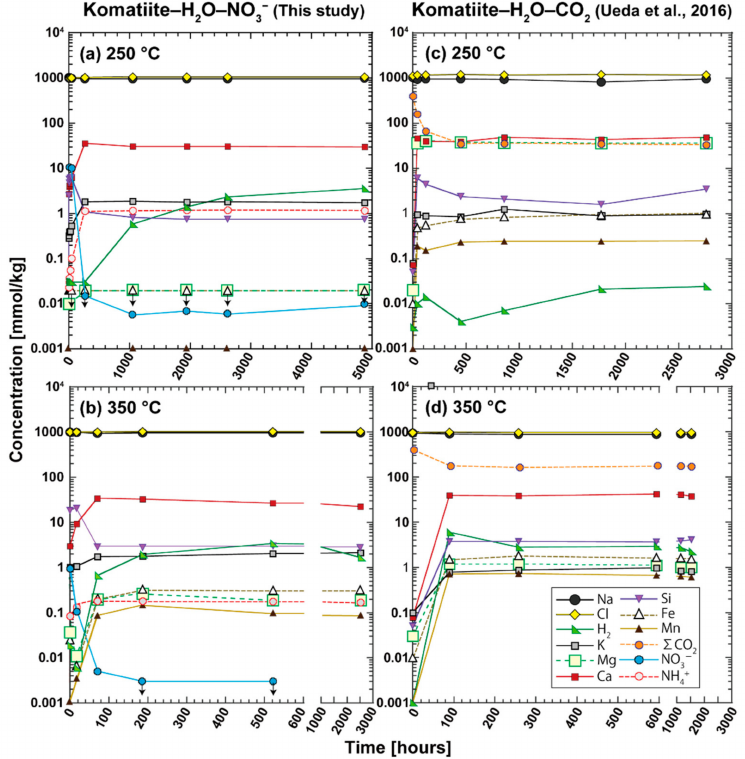
Figure 1. Measured concentrations of dissolved species in an aqueous fluid coexisting with komatiite and its alteration products as functions of time at 250 ◦ C ( a , c ) and 350 ◦ C ( b , d ), 500 bars. ( a , b ) Fluid compositions in the komatiite–H 2 O–NO 3– system at 250 ◦ C and 350 ◦ C with the initial water–rock mass ratios of 7 and 5, respectively. ( c , d ) Fluid compositions in the komatiite–H 2 O–CO 2 system at 250 ◦ C and 350 ◦ C with the initial water–rock mass ratios of 5 and 5, respectively (Ueda et al., 2016). White triangles and light-blue circles with black arrows imply that iron and nitrate concentrations in plot are the maximum estimates (0.02 mmol/kg for iron in N250, 0.003 mmol/kg for nitrate in